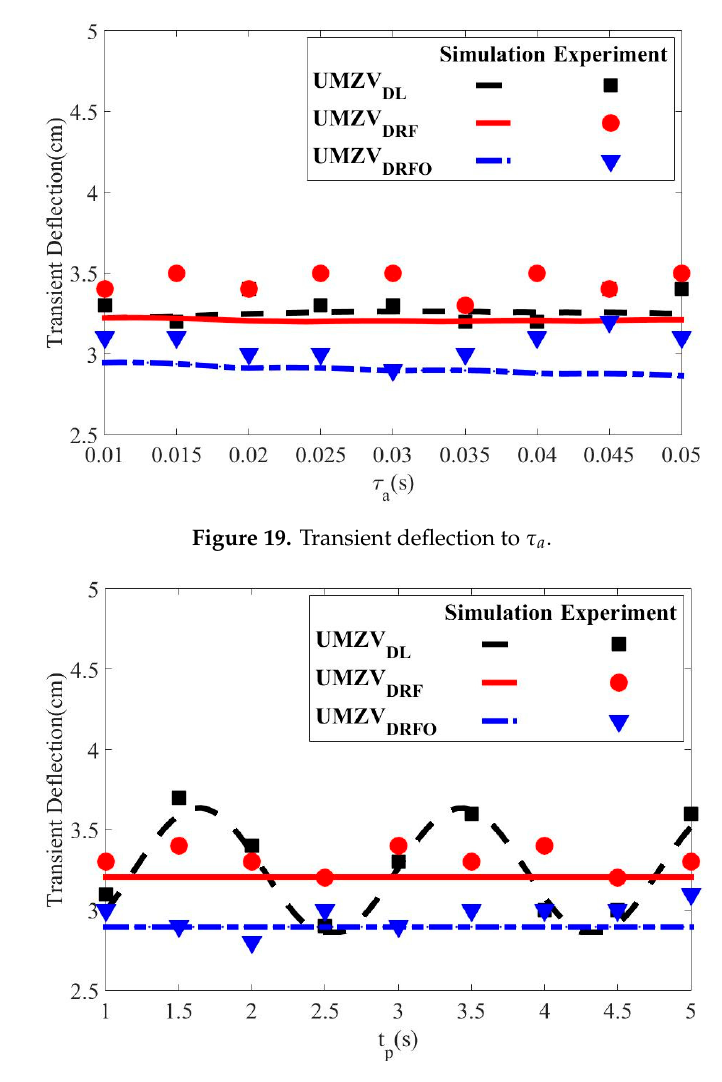
Figure 20. Transient deflection to (cid:1872) (cid:3043) .